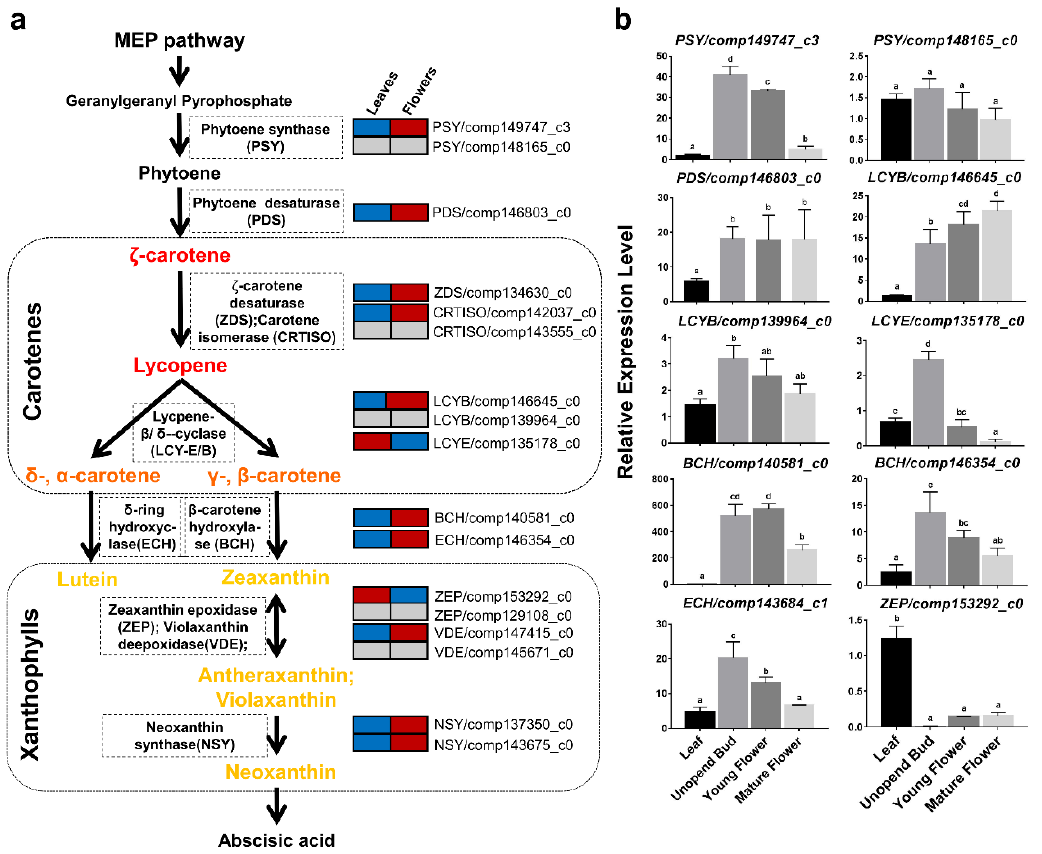
Figure 4. Schematic representation of key transcript expressions in the carotenoid biosynthesis pathway of O. dubium . ( a ) Comparison of carotenoid-related transcript expressions between the leaves and flowers based on the transcriptome profiling in O. dubium line 5. Gene expression is shown for leaves (left block) and flowers (right block); red represents a higher level of expression of genes, and blue indicates a lower level of expression, while grey means no differences in expression between the two tissues. ( b ) Relative levels of expressions of 10 candidate key transcripts in various tissues (leaves and flowers during three developmental stages) of O. dubium line 5. Data from qRT-PCR were normalized with respect to the gene expression of actin3 and presented as the mean with a standard deviation of three biological repeats with three replicates each.